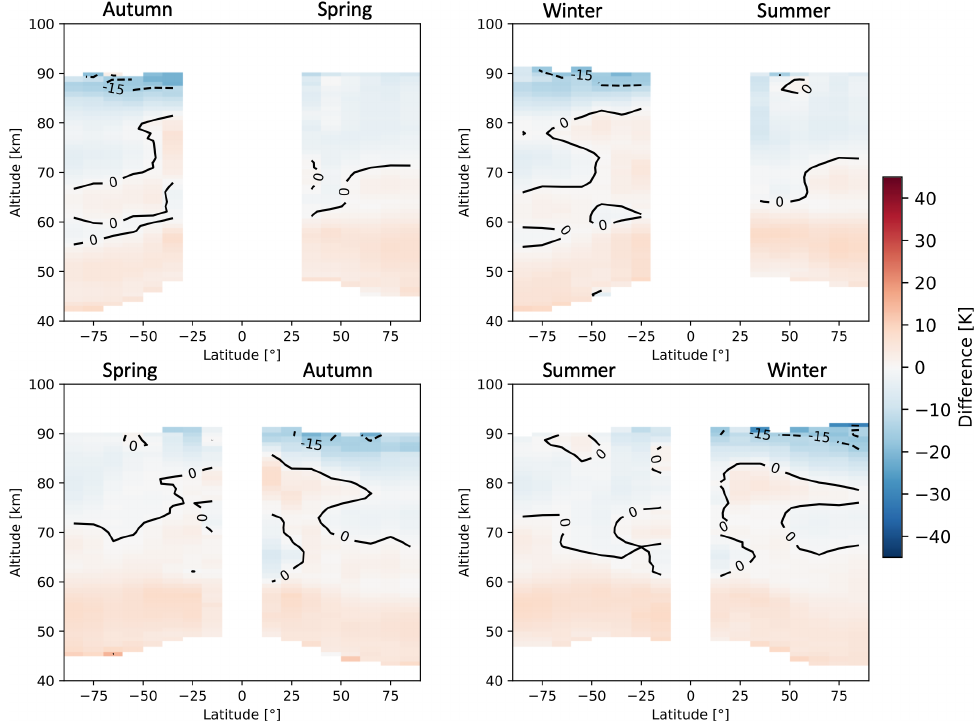
Figure A31. Seasonal zonal means of temperature FM19 SMR–MLS absolute differences averaged over the time period between July 2004 and April 2019. The seasons are intended as astronomical seasons, i.e. each starting at the respective solstice or